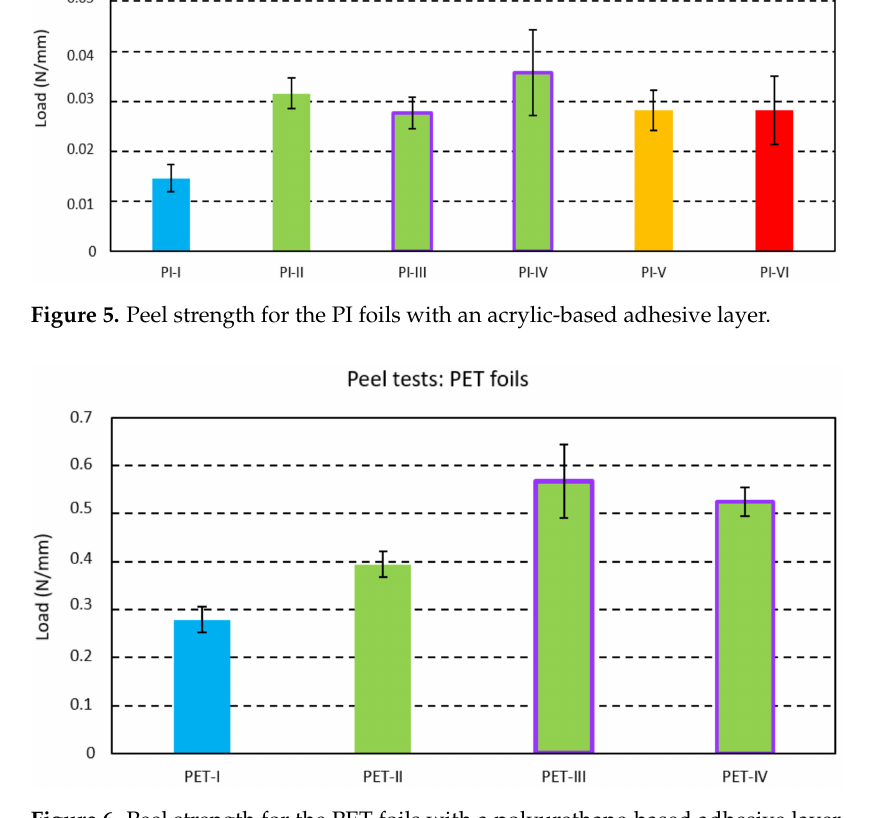
Figure 6. Peel strength for the PET foils with a polyurethane-based adhesive layer. One-Way ANOVAs with Tukey tests (with 95% confidence interval) for the PI foils (from PI-I to P-VI) yielded a significantly lower adhesion for the foil molded at the low mold temperature (PI-I). While increasing the mold temperature from 80 ◦ C (PI-I) to 100 ◦ C (PI-II) increased the adhesion, a further increase to 120 ◦ C (PI-VI) could not be confirmed